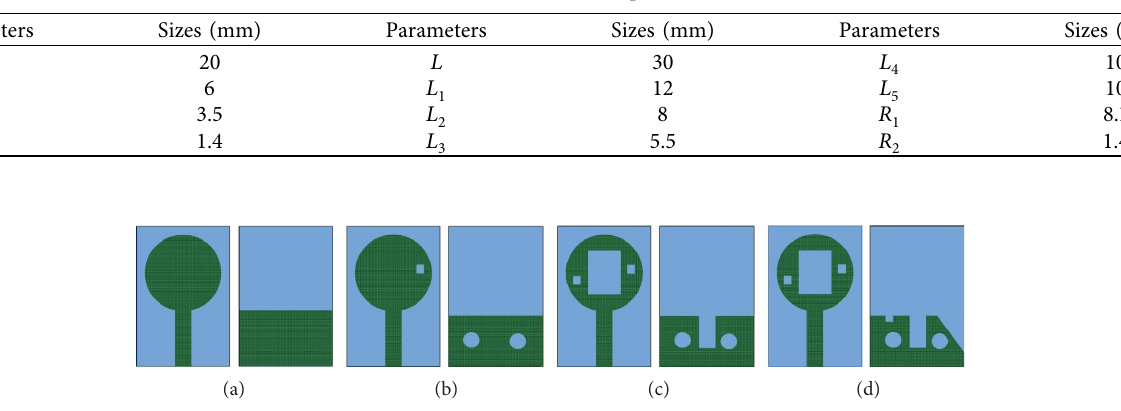
Table 1: Antenna basic size